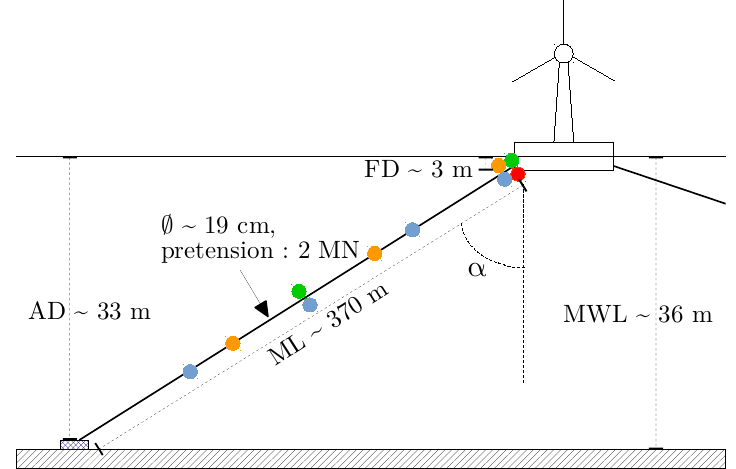
Figure 15. Mooring line of a FWT, monitored by four configurations of tension sensing